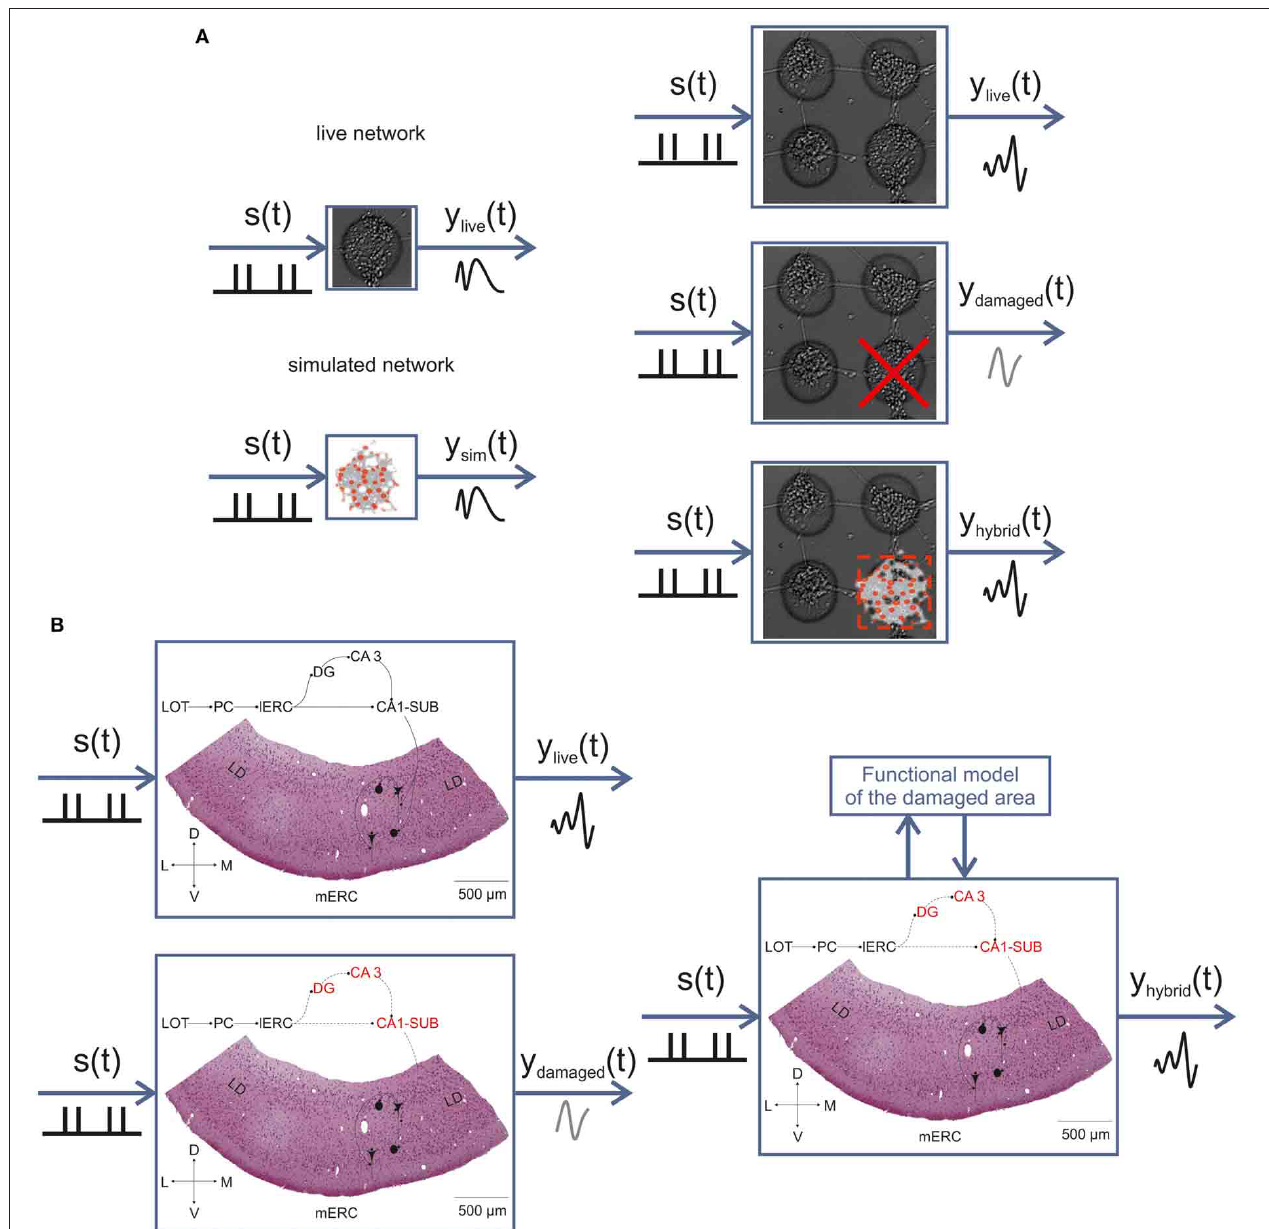
hippocampus (B) . The bidirectional interaction with a model reproducing the function of the damaged area will allow restoring the original I/O pattern. s( t ): stimulus function; y live ( t ): response function of a healthy preparation; y sim ( t ): response function of the neuronal network model; y damaged ( t ): response function after lesion in the IWB; y hybrid ( t ): response function of the hybrid system resulting from the combination of biological and artificial components. In panel (B) , the hippocampal areas targeted by the ischemic lesion are marked in